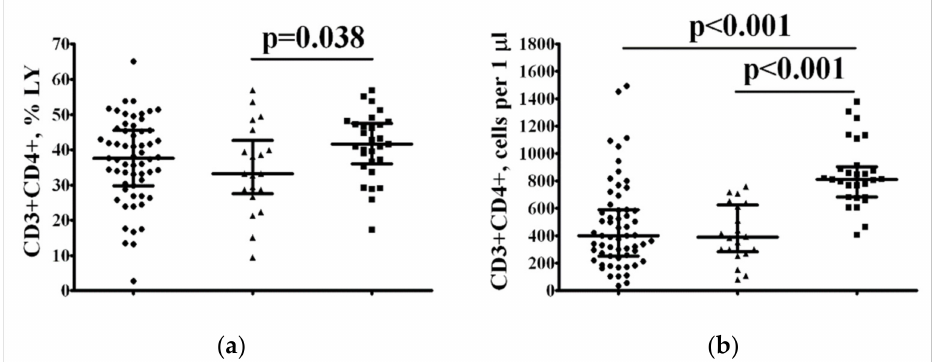
Figure 3. The frequency of peripheral blood CD3+CD4+ Th cells in patients with COVID-19 and 25(OH)D > 11.4 ng/mL or 25(OH)D ≤ 11.4 ng/mL. Scatter plots show the relative ( a ) and absolute ( b ) numbers of CD3+CD4+ T-lymphocytes in peripheral blood samples from patients with COVID-19 and 25(OH)D > 11.4 ng/mL (black circles, n = 59), patients with COVID-19 and 25(OH)D ≤ 11.4 ng/mL (black triangles, n = 20), and HC subjects ( n = 28, black squares). Numbers represent the percentages of the indicated Th cell subset among the total lymphocyte population. Each dot represents an individual subject, and the horizontal bars represent the group medians and interquartile ranges (Me [IQR 25;